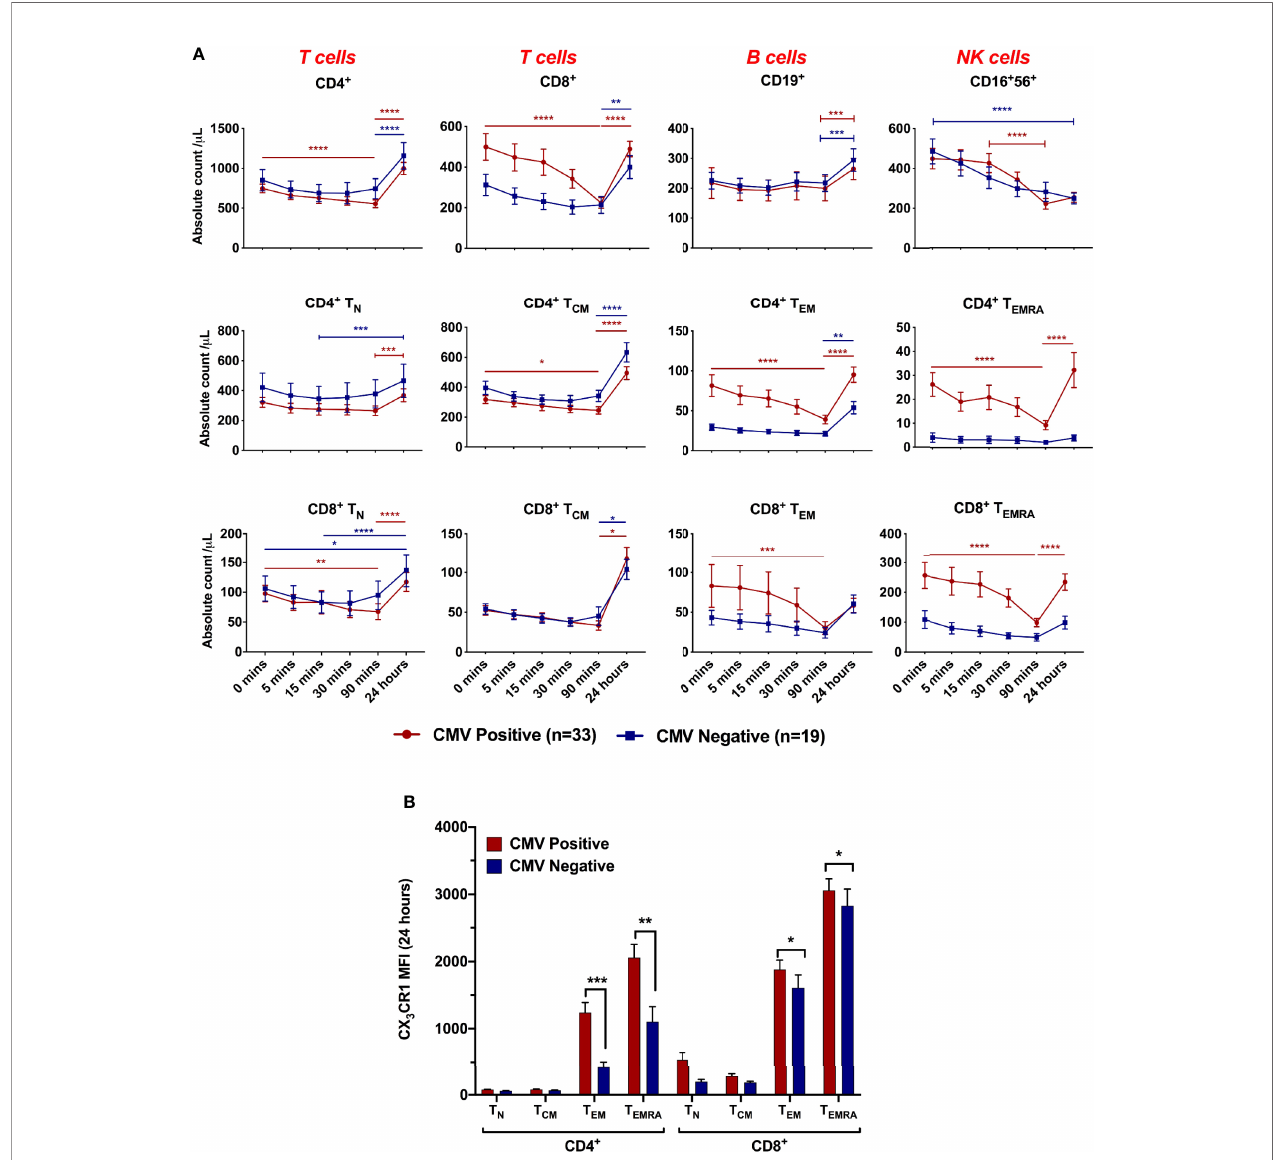
FIGURE 3 | Lymphocyte dynamics during ischaemia/reperfusion depending on CMV serostatus. (A) Absolute count of lymphocyte subsets by time point. 0 minutes represents pre-reperfusion, other time points are post-reperfusion. CD4 + , CD8 + and CD16 + 56 + cells dropped between 0 and 90 minutes post-reperfusion, and CD4 + and CD8 + cells rebounded at 24 hours. CMV seropositive patients had more effector memory cells and showed sharper drops by 90 minutes. Dynamics were signi fi cantly affected by CMV serostatus in CD8 + (p=0.05) CD4 + T EM (p=0.002), CD4 + T EMRA (p=0.002) and CD8 + T EMRA (p=0.003). n=52. Horizontal lines display statistical signi fi cance across time points for CMV seropositive (red) and seronegative (blue) patients. *=p<0.05; ** = p<0.01; *** = p<0.001; *** = p<0.0001. p values determined using 2-way ANOVA. (B) Mean CX 3 CR1 expression on each T-cell subset at 24 hours